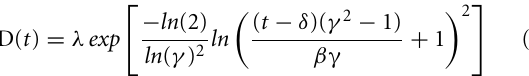
FIGURE 3 | Analysis measures derived from the log-normal peak function parameters. δ indexes the peak location in time (henceforth called “initial uncertainty time” since proportions of looks to the target vs. distractor do not diverge up to this point, see Figure 2 ); the peak amplitude λ is a measure of overall error rate (complementary to accuracy; note that we are modeling proportions of looks to the distractor); the compound measure γ × β /(1 + γ ) (henceforth called “home-in time”) captures the time that elapses between the peak location δ and the point in time where error rate has dropped to ½ λ in the right tail of the